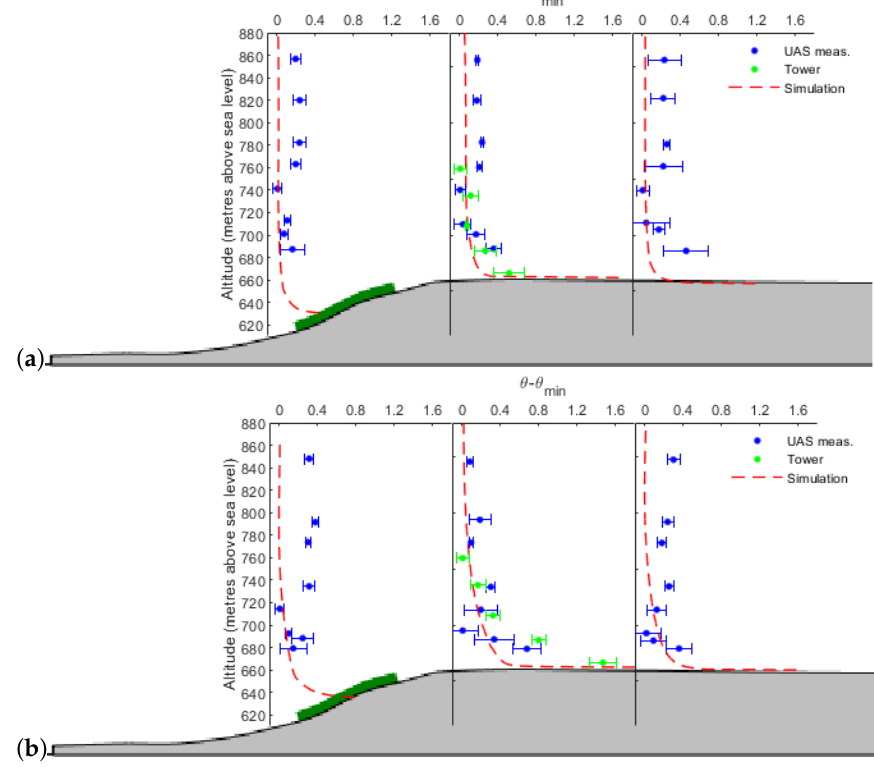
Figure 14. Vertical profiles of potential temperature differences (potential temperature minus its minimum value) from the MASC (blue dots), the tower (green dots) and the simulation (red lines) over, behind and further downstream the escarpment on 21 ( a ) and 22 ( b )